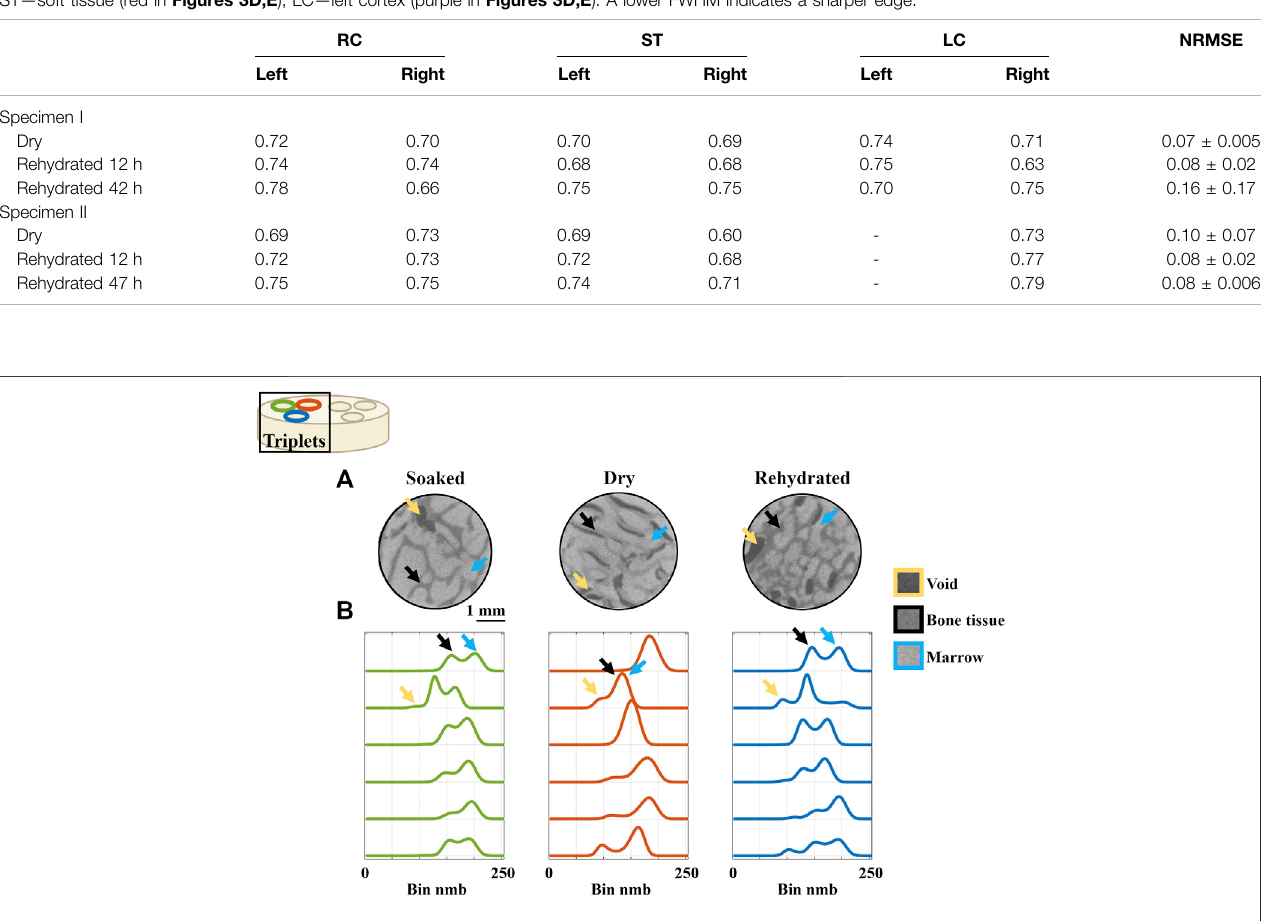
Frontiers in Bioengineering and Biotechnology |